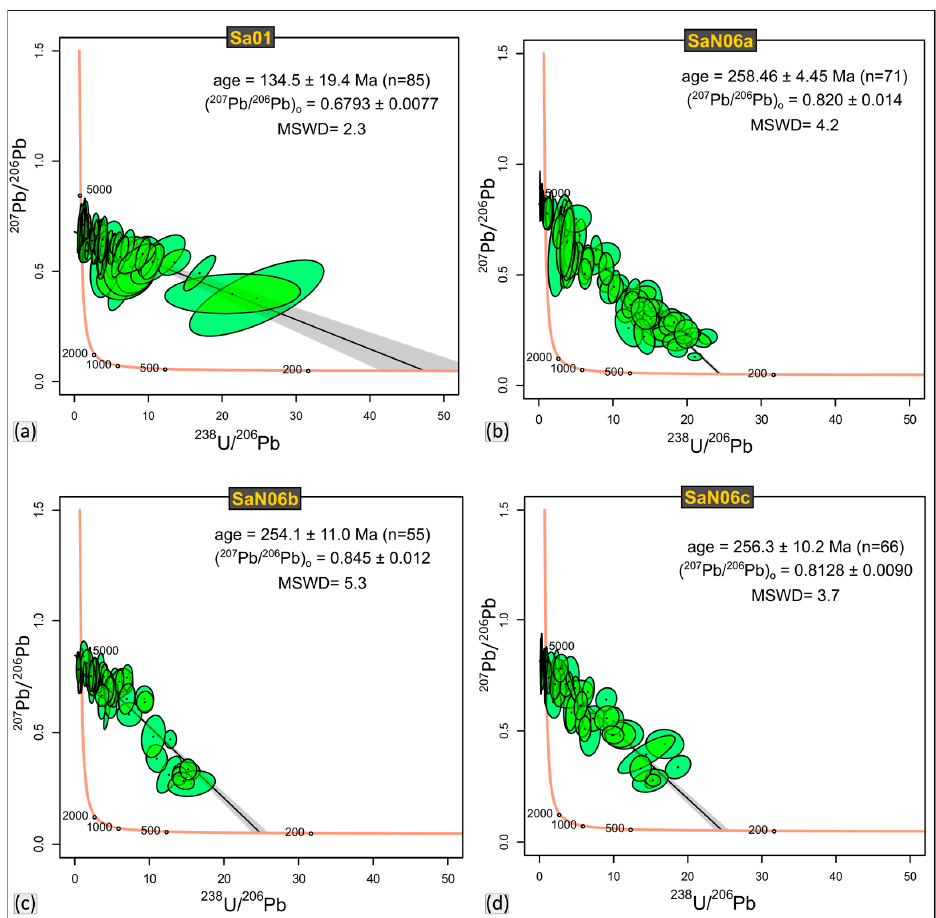
Figure 12. Tera–Wasserburg diagram of measured in situ calcite 207 Pb/ 206 Pb and 238 U/ 206 Pb ratios (no common lead correction) from ( a ) sample SaN06a, ( b ) sample SaN06b, ( c ) sample SaN06c, ( d ) sample Sa01 Error ellipsoids of spot analysis are plotted in green and represent 2 σ uncertainties. MSWS = mean standard weighted deviation.